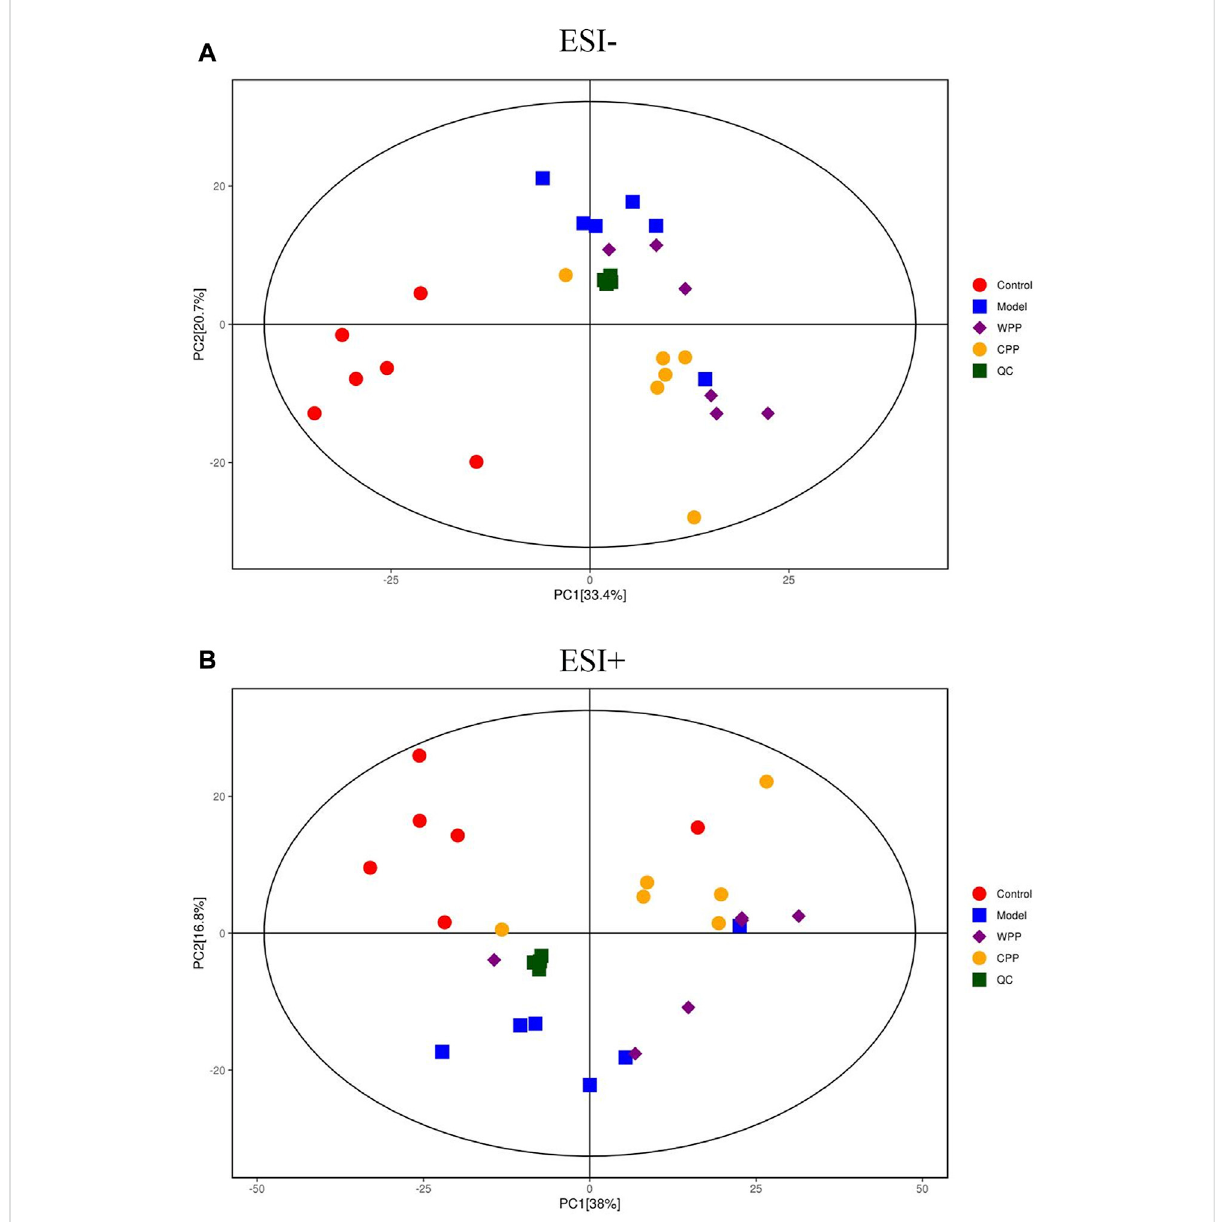
FIGURE 6 Principal component analysis (PCA) score plot of the control group, model group, WPP-treated group (40 μ g/ml) and CPP-treated group (40 μ g/ml) in the negative ion mode (NEG) (A) and positive ion mode (POS) (B) ( n =